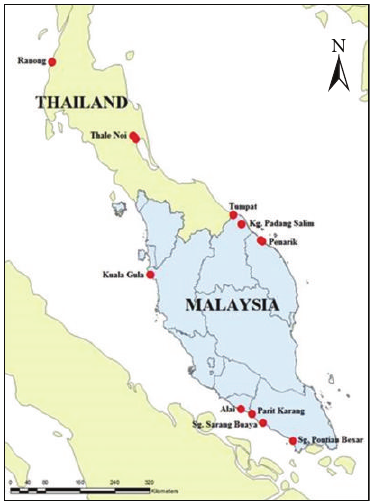
Figure 1: Sampling location of otter samples used in this study.